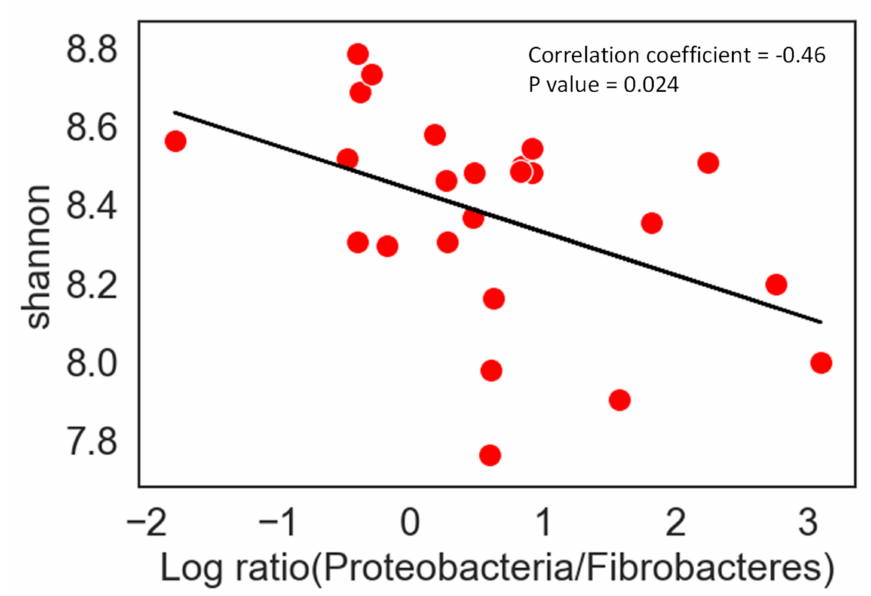
Figure 4. Correlation between the Shannon index and the Proteobacteria/Fibrobacteres ratio (ex- pressed in log) in ponies and